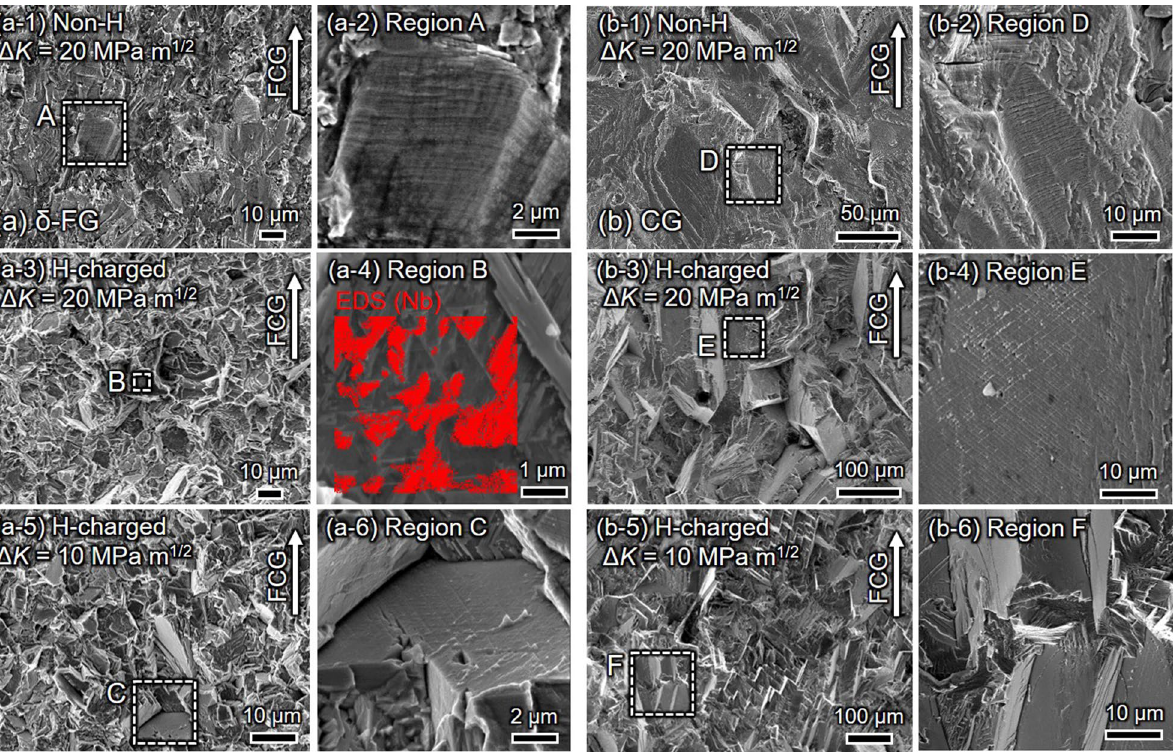
Figure 2. SEM images of the fracture surfaces for ( a ) δ-FG and ( b ) CG at Δ K = 20 MPa m 1/2 and Δ K = 10 MPa m 1/2 : ( a-1,a-3,b-1,b-3 ) are for the absence and presence of H, respectively, at Δ K = 20 MPa m 1/2 . ( a-5,b-5 ) are for the presence of H in δ-FG and CG, respectively, at Δ K = 10 MPa m 1/2